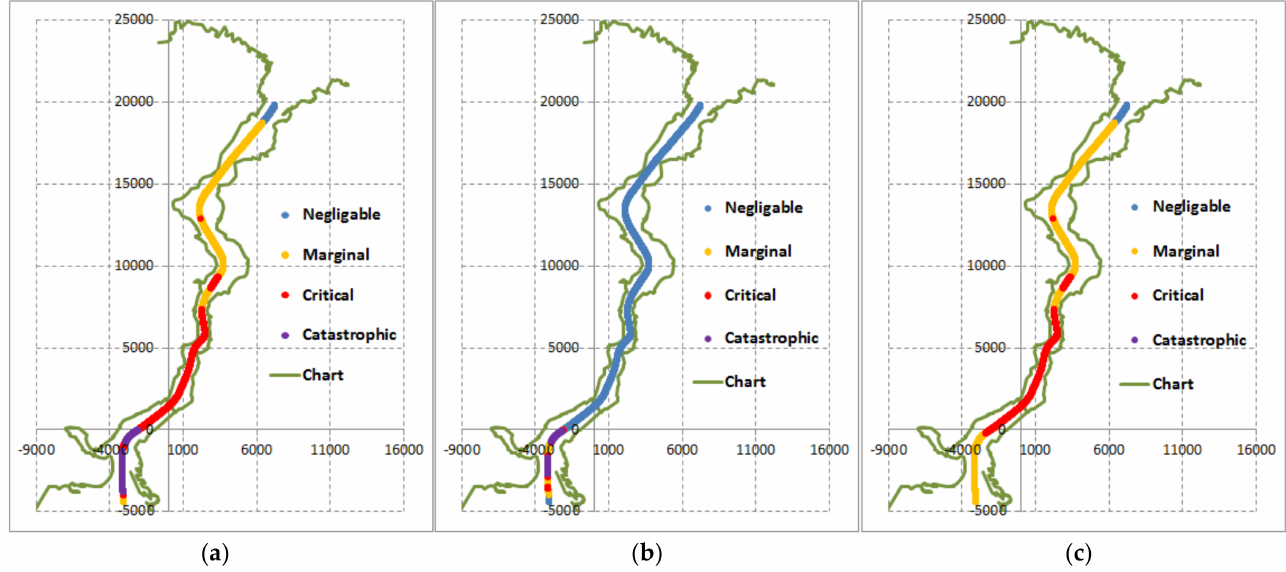
Figure 3. Northbound schematic representation of 330 m Bulk Carrier: ( a ) ES-A; ( b ) ES-S; ( c )